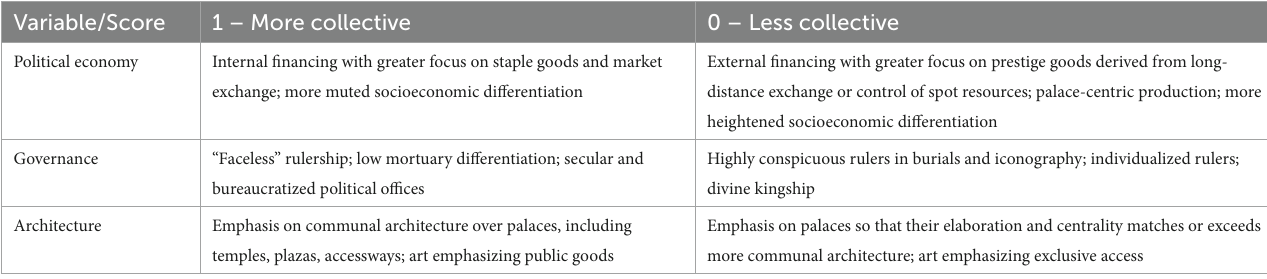
TABLE 1 Axes of collectivity * coded for Mesoamerican cases.